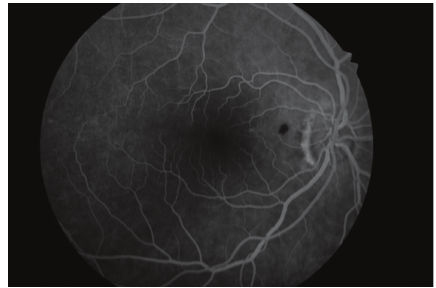
Figure 3: Fluorescein angiography showed blockage of fluorescence due to pigmented tumor and no leakage was observed.